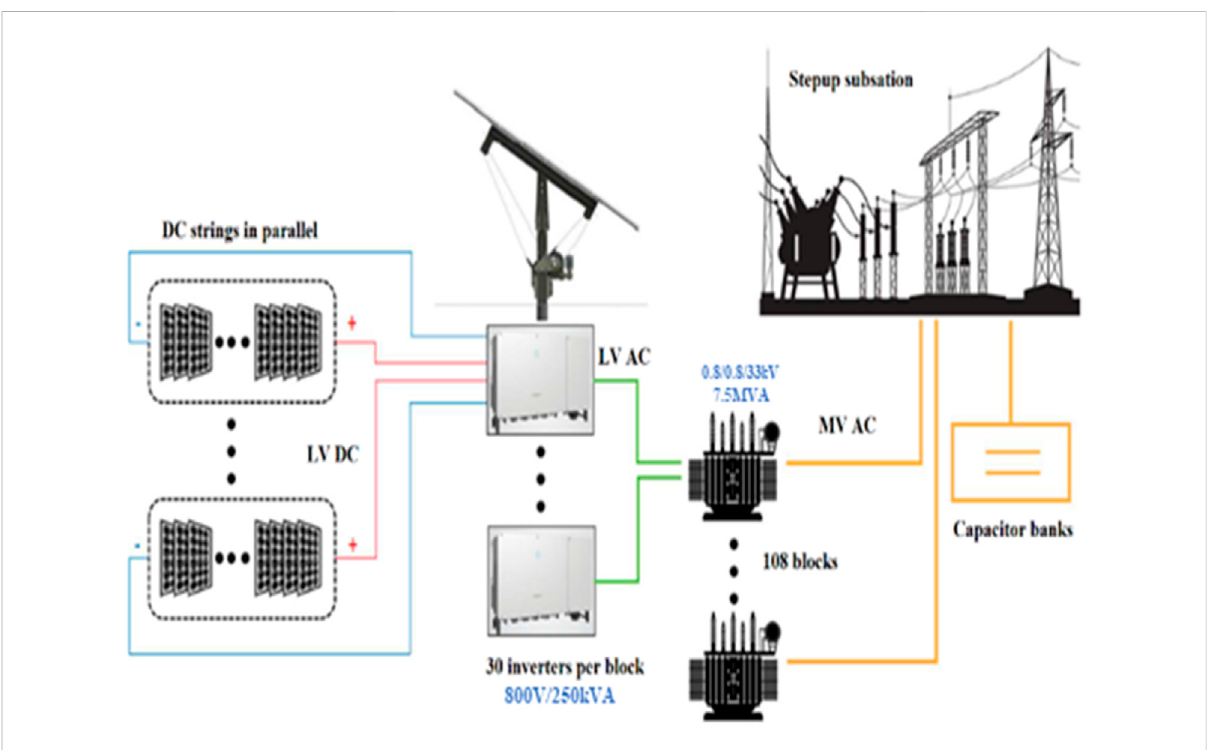
FIGURE 8 PV farm structure.